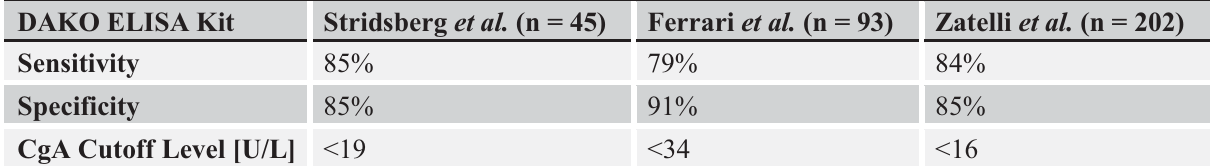
Table 8. Sensitivities and specificities of CgA depending on different cutoff levels (DAKO ELISA kit).